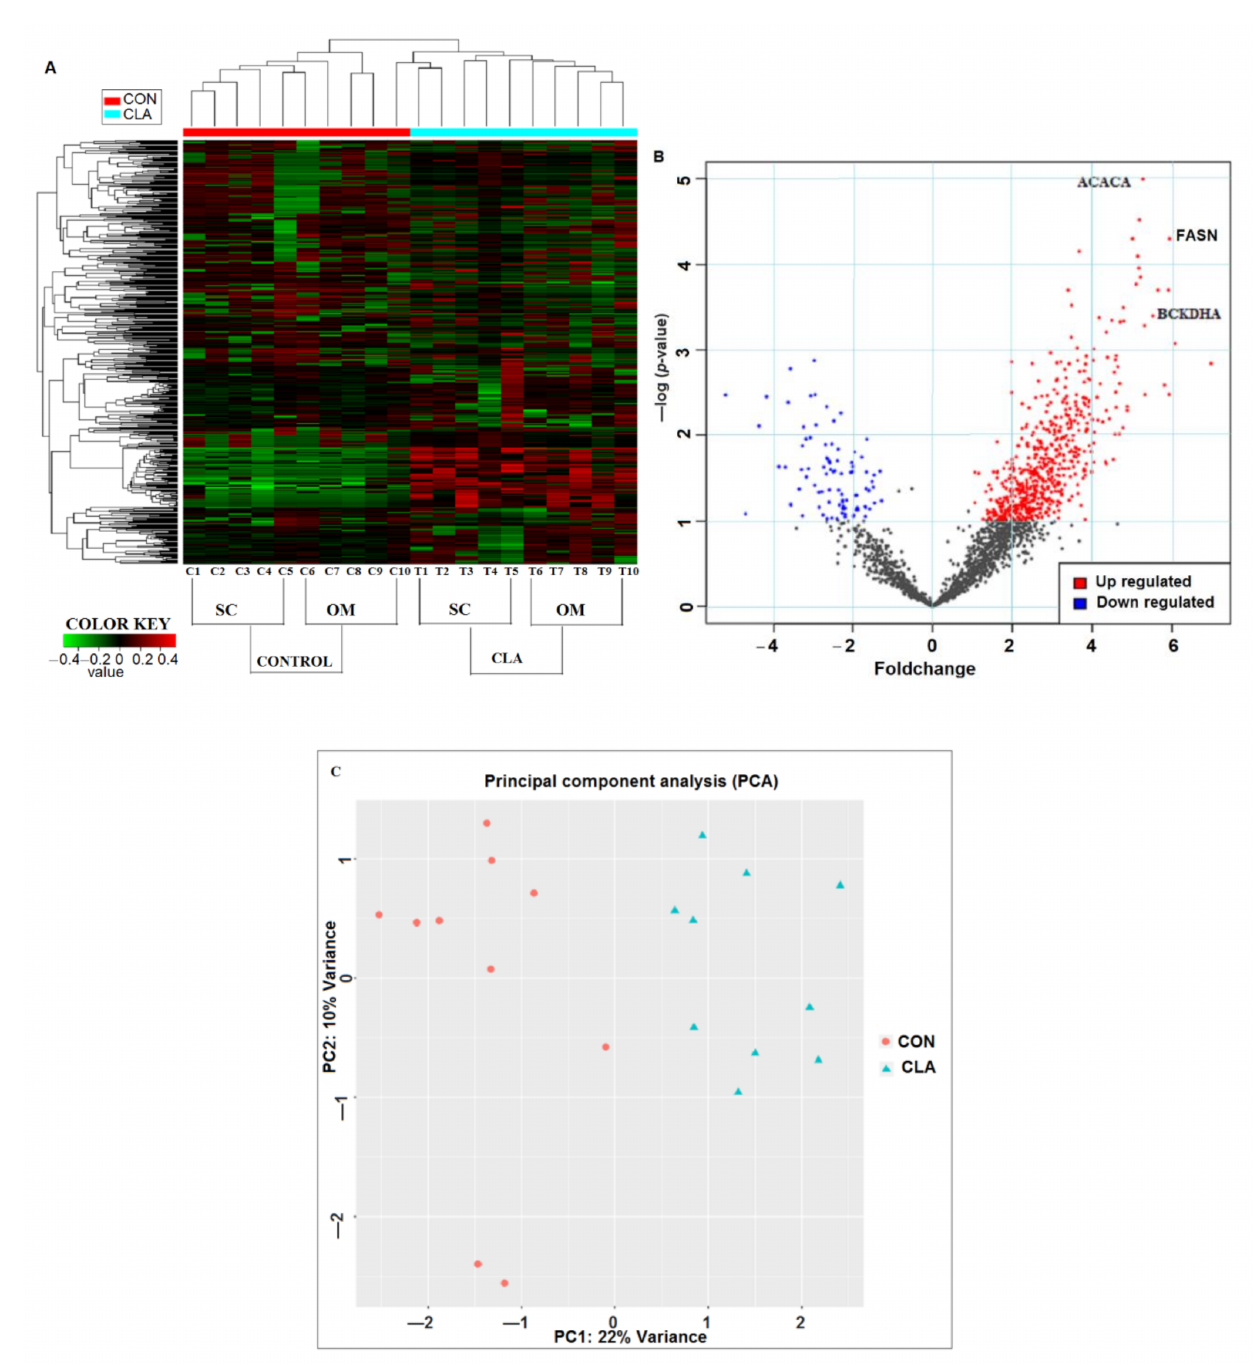
Figure 2. Differential expression analysis of phosphoproteome by IDEP 9.1 server using fold change and p-values of phosphopeptides. ( A ) Heat map analysis of significantly expressed phosphopeptides of control cow subcutaneous (SC) AT (C1–C5); control cow omental (OM) AT (C6–C10); CLA-supplemented cow SC AT (T1–T5); CLA supplemented OM AT (T6T10). The data represent the mass intensity of each peptide in the individual cows. Red boxes indicate upregulation, green boxes represent downregulation, and black boxes represent no change. ( B ) Volcano plot illustrates the significant expressed peptides of CON vs. CLA-supplemented dairy cows. The significant upregulated peptides are in red color and downregulated are in blue color. X -axis represents fold change and y -axis represented p -value. FASN-fatty acid synthase; ACACA-acetyl-CoA carboxylase 1; BCKDHA-branched-chain keto acid dehydrogenase E1 alpha. ( C ) Principal component analysis (PCA) of 22% variance in CON vs. CLA-supplemented SC and OM AT. PCA representing the separation of CON (red circles) with CLA-supplemented (blue triangles)